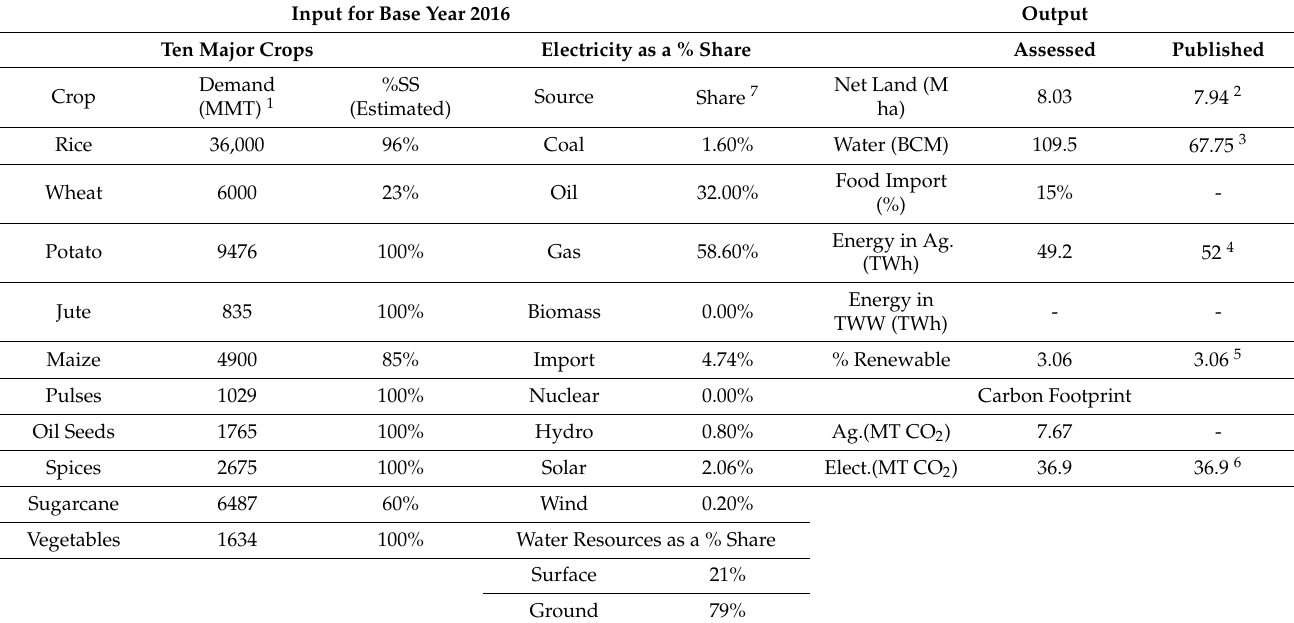
Table 1. Inputs and assessments for base year 2016 in comparison with published data sources.